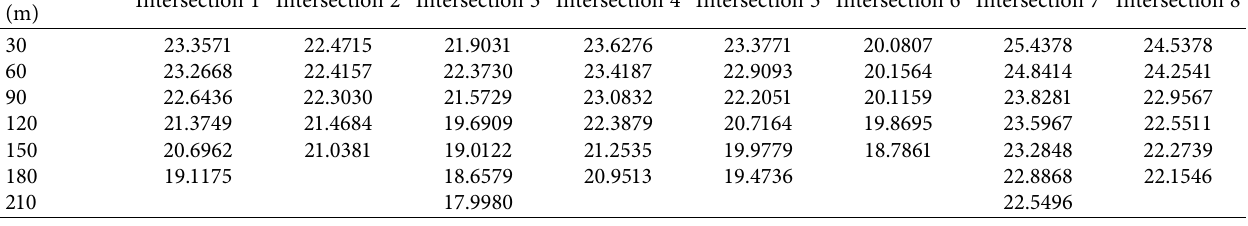
Table 8: LST of intersection areas’ diffusion in